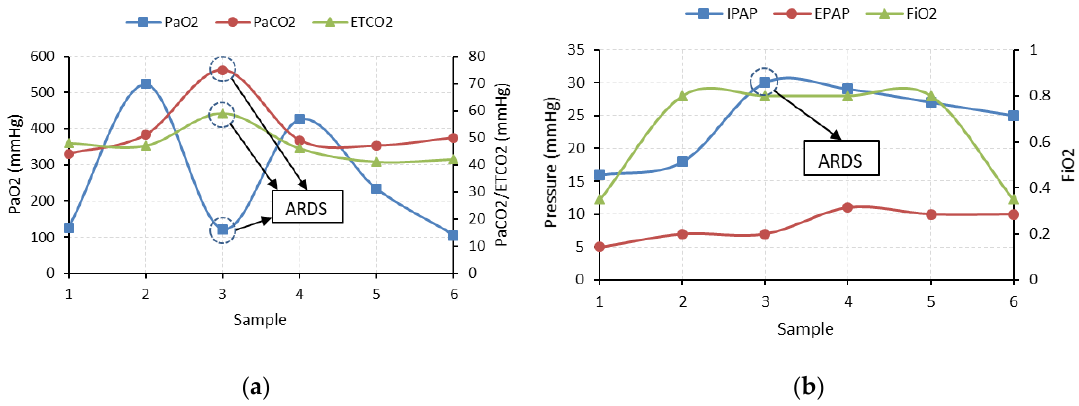
Figure A3 Animal test: ( a ) PaO 2 , PaCO 2 , and ETCO 2 ; ( b ) IPAP, EPAP, and FiO 2 . Figure A3. Animal test: ( a ) PaO 2 , PaCO 2 , and ETCO 2 ; ( b ) IPAP, EPAP, and FiO 2